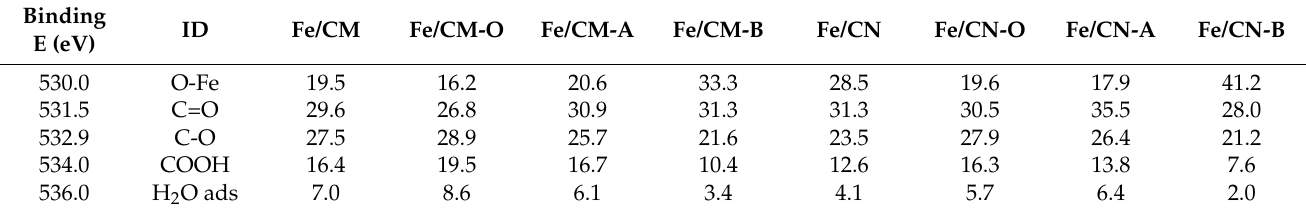
Table 3. Contribution (%) of different peaks to the O1s XPS